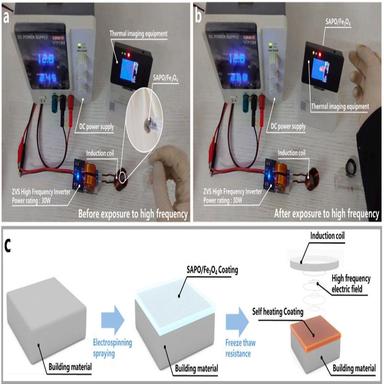
a–c Self-heating behavior of geopolymer nanofibers in a high-frequency electric field: (a) Induction heating system and the self-heating test method; (b) Infrared thermal image of the nano geopolymers after exposure to a high-frequency electric field, taken through thermal imaging equipment; (c) Schematic illustration of functionalized nano geopolymers used for anti-ice treatment.